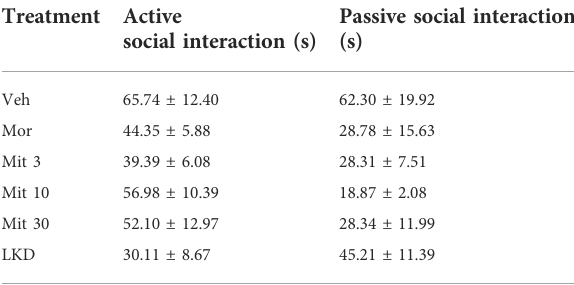
TABLE1Activeandpassivesocialinteractionafterexposuretokratom during adolescence. Data are expressed as mean ±